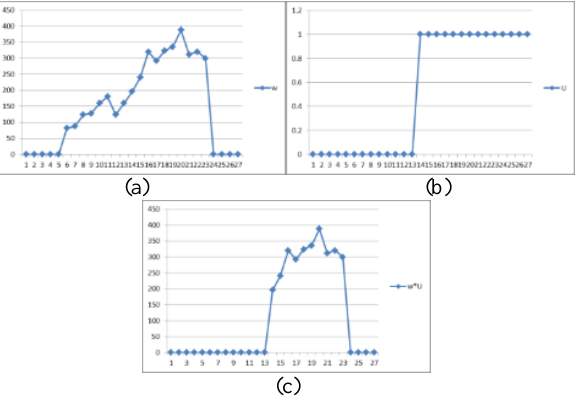
Figure 12. Broken line graph of side length and interruption of AOI in sequence